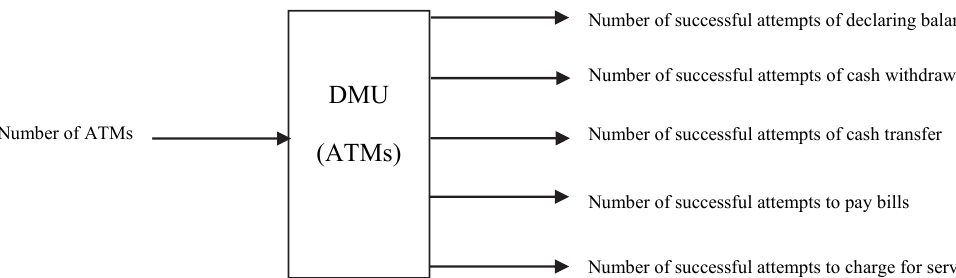
Fig. 2. The input and the output of DEA model for measuring the efficiency of ATMs